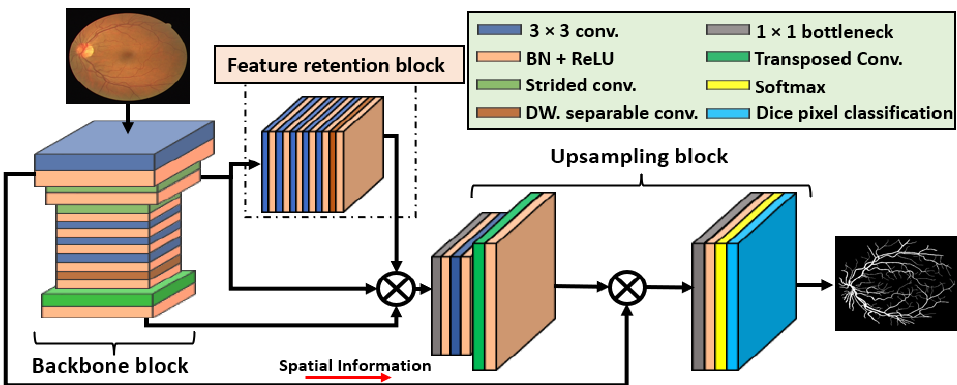
Figure 2. The structure of the proposed VSUL-Net. In this figure, 3 × 3 kernel convolution (3 × 3 conv.), 1 × 1 convolution (1 × 1 bottleneck), batch normalization and rectified linear unit (BN + ReLU), 2 × 2 transposed convolution with stride = 2 (Transposed Conv.), 3 × 3 convolution with stride = 2 (Strided conv.), and 3 × 3 depth-wise separable convolution (DW. separable conv.) are represented.